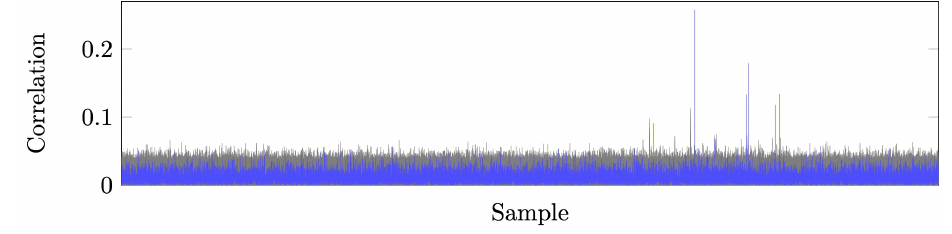
Figure 4: Correlation score when targeting at the 2 nd bit in the first s-box in the last round with data-dependency integrated HO-DCA using 5 thousand traces where the duplicated samples have been reduced. The blue curve is for the correct key guess and the gray curves are for the incorrect key